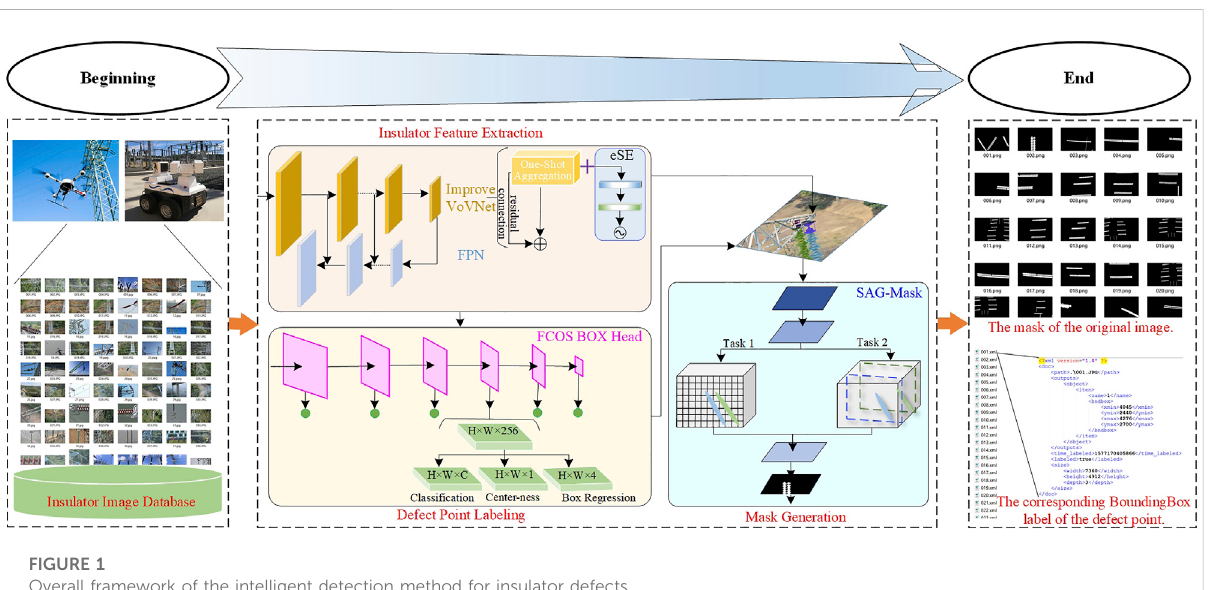
FIGURE 1 Overall framework of the intelligent detection method for insulator